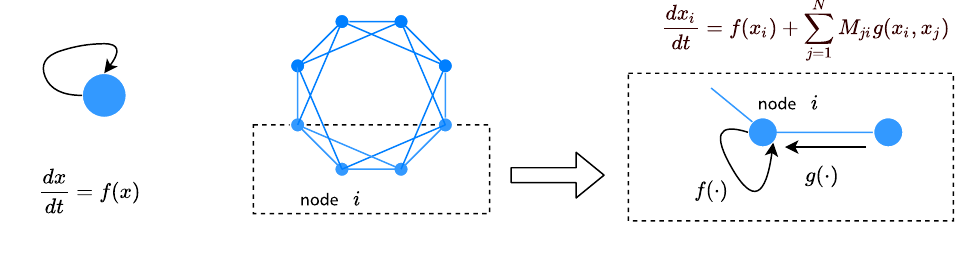
Figure 1. It shows the dynamics of one-dimensional system and multi-dimensional system. In a one- dimensional system, node behavior is controlled only by the self-dynamics f ( · ) . ( b ) In a multi-dimensional dynamic system, node behavior is characterized by the self-dynamics f ( · ) and the coupling dynamics g ( · ) .